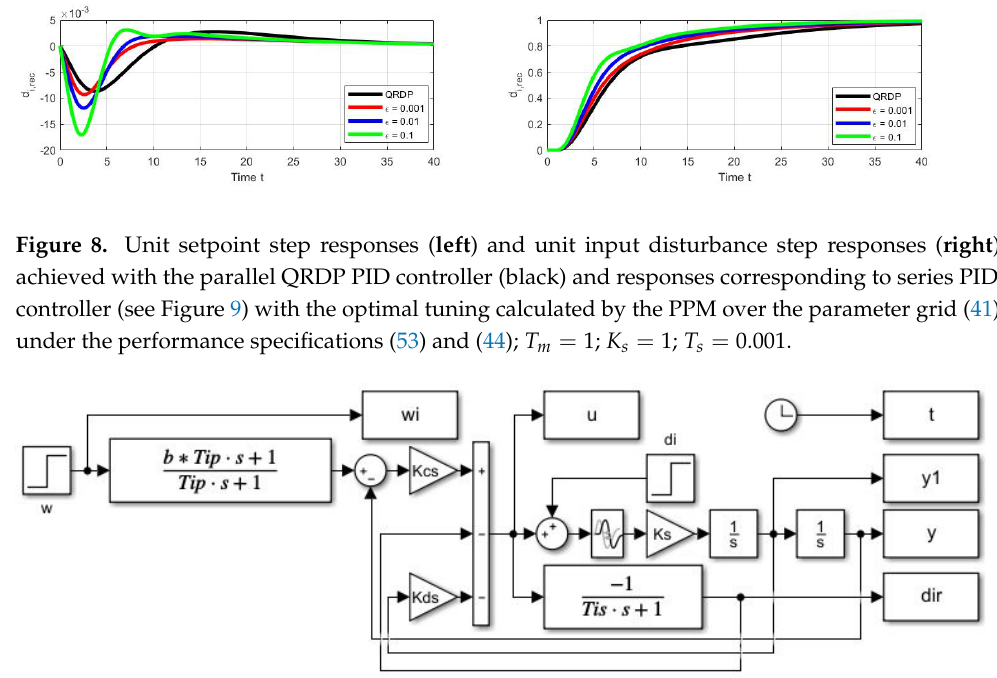
Figure 9. Matlab/Simulink simulation scheme with series PID controller used to verify controller tuning calculated from the PP (41) derived for the parallel PID control; the prefilter F p ( s ) = ( 1 + bT ) / ( 1 + T ) (42) still corresponds to the parallel PID tuning. ip s ip s The resulting waveforms of the individual circuit responses are presented in Figure